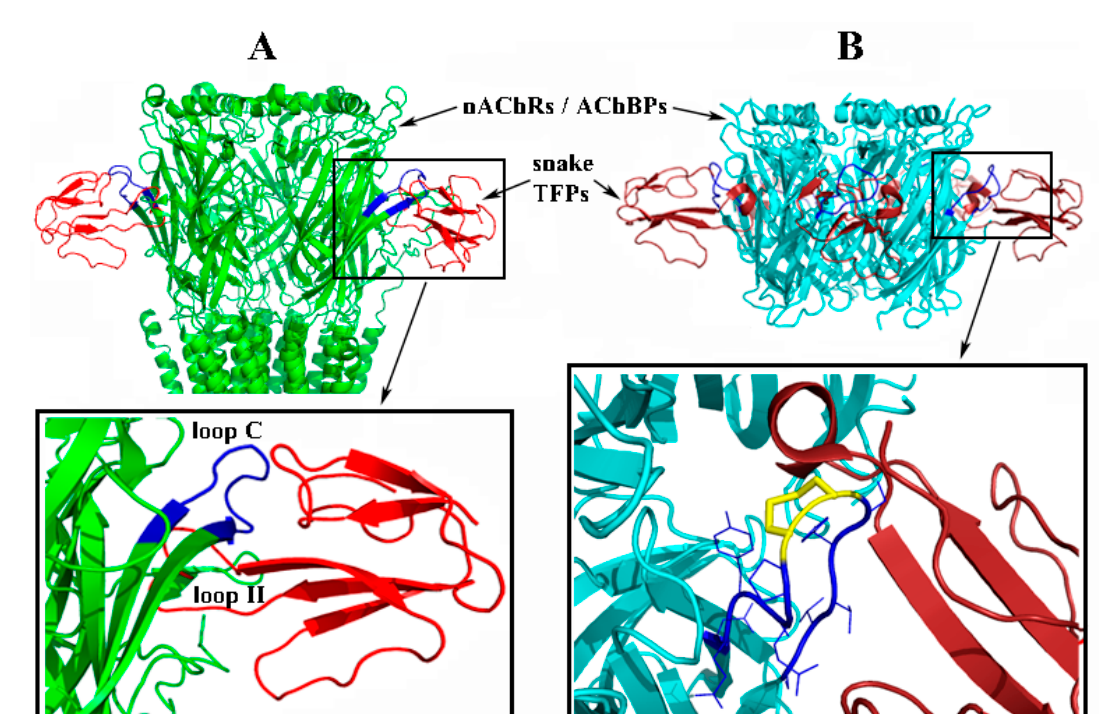
Figure 6. Cartoon-presentations of high resolved structures of nAChRs/AChBPs complexed with snake TFPs. ( A ) A portion (ligand-binding domains with top part of trans-membrane α -helixes) from cryo-EM structure of a native Torpedo electric ray nAChR (green) in complex with α -Bgt from Bungarus multicinctus (red) (PDB ID: 6UWZ). Loops C of the two α -subunits of the receptor are marked in blue. The inset shows the location of loop C and the central loop II of the toxin at an enlarged scale. ( B ) X-ray structure of AChBP from L. stagnalis mollusk (cyan) in complex with α -cobratoxin from Naja kaouthia (ruby) (PDB ID: 1YI5). All five loops C of the protein are marked in blue. The inset shows at an enlarged scale the location of the toxin central loop II and AChBP loop C (amino acid residues 202–214) with the side chains (vicinal disulfide CC 207 − 208 is marked in yellow).